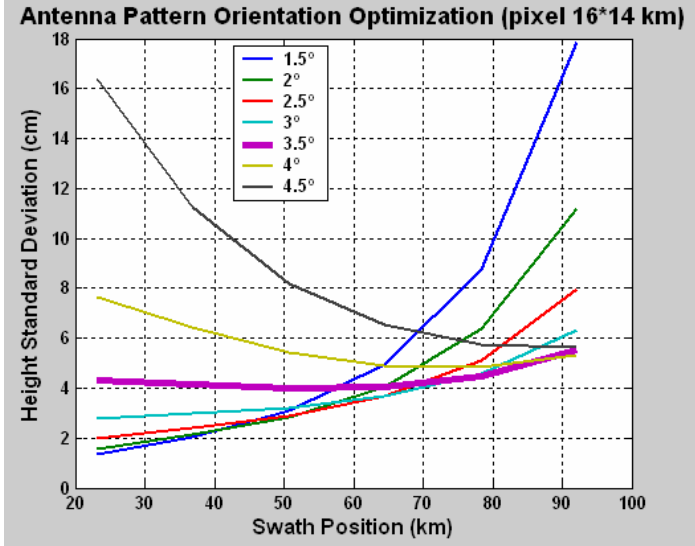
Figure 7. Antenna Pattern Orientation